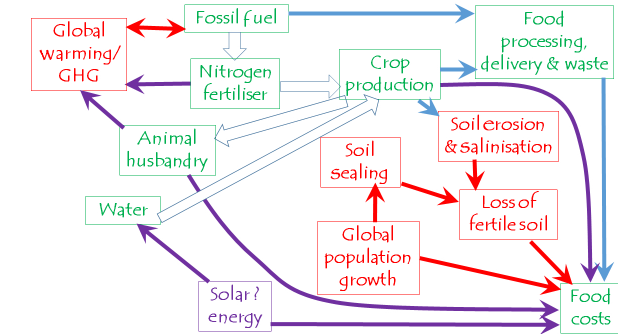
Figure 11. Factors influencing the relationships between water use and the cost of food, taking account of energy needs for fertiliser and possible water desalination, loss of cultivable land and green- house gas